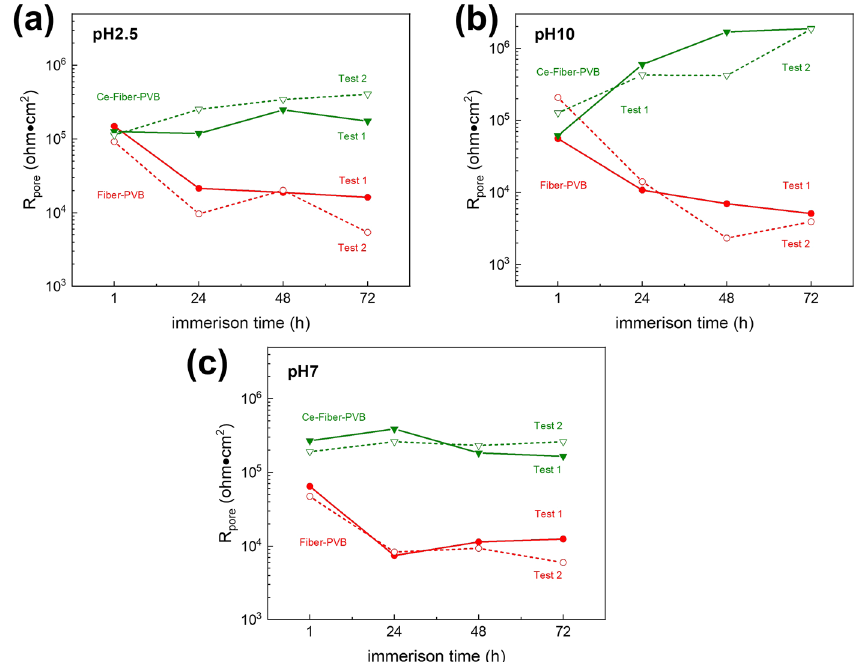
Fig. 5 Evolution of R pore of Fiber-PVB and Ce-Fiber-PVB at different pH conditions. Coated samples were immersed in 5 mM Na 2 SO 4 with pH a 2.5, b 10, c 7.